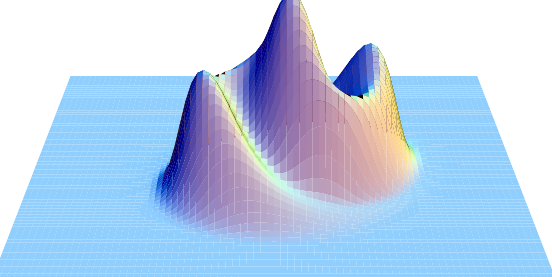
FIG. 15. (Color) Phase-space distribution of a 200 mA fully stretched unstable bunch that does not have a relaxation cycle. The ring impedance consists of main-cavity and harmonic- cavity fundamental rf modes realistically detuned for beam- loading compensation. Machine parameters are given in Table I.